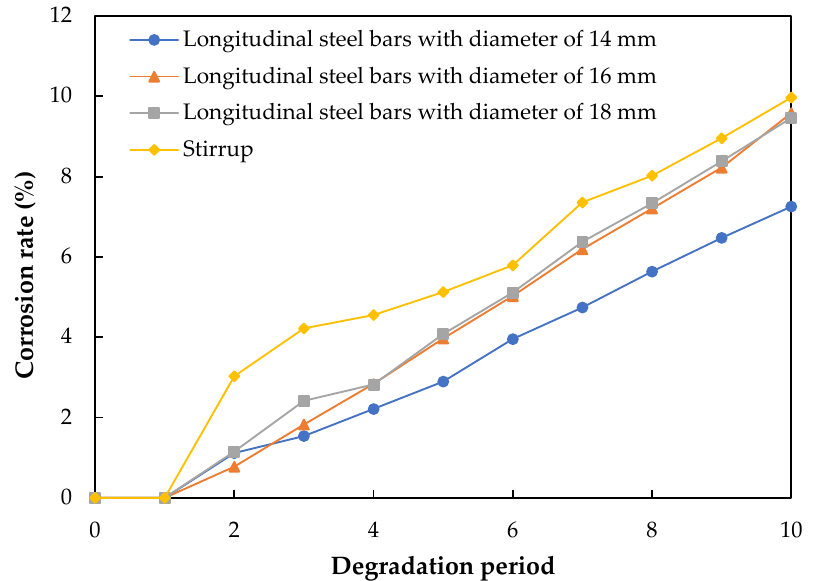
Figure 9. Average corrosion rate of stirrups and longitudinal steel bars with diameters of 14, 16 and 18 mm in the degradation periods 0–10.